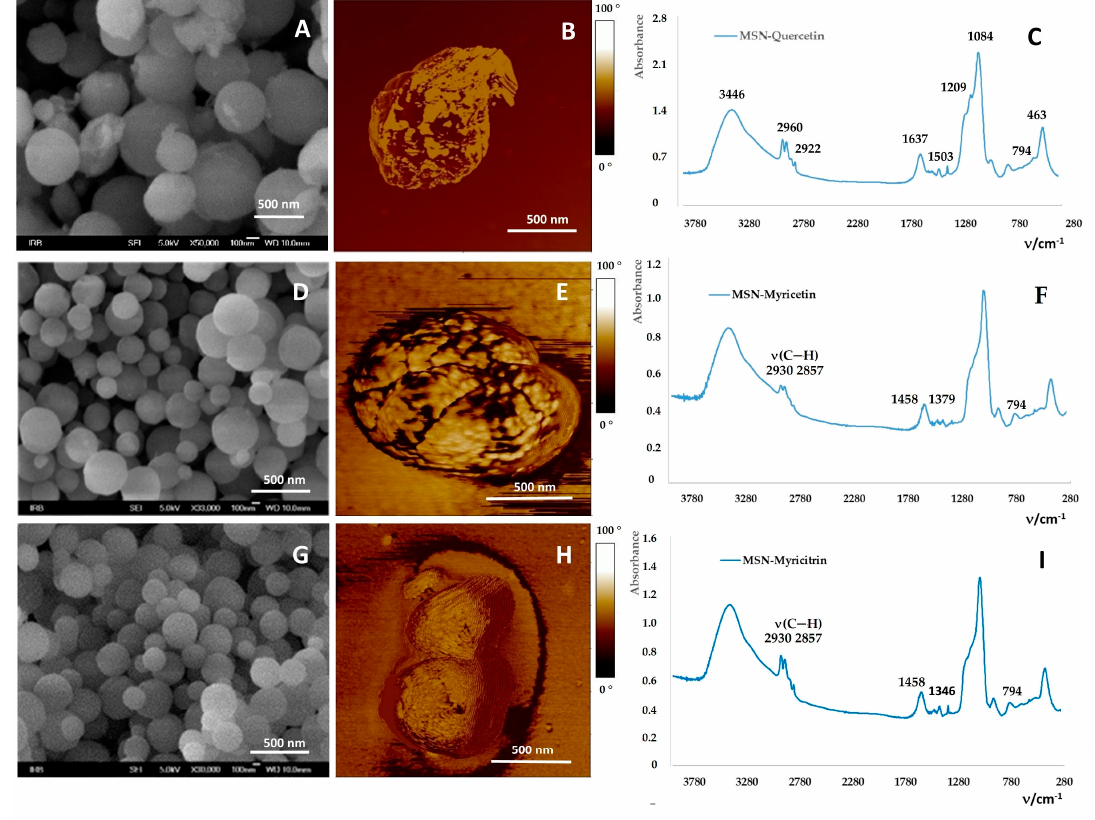
Figure 4. ( A – C ) Characterization of flavonoid loaded MSNs: With quercetin, ( D – F ) myricetin and